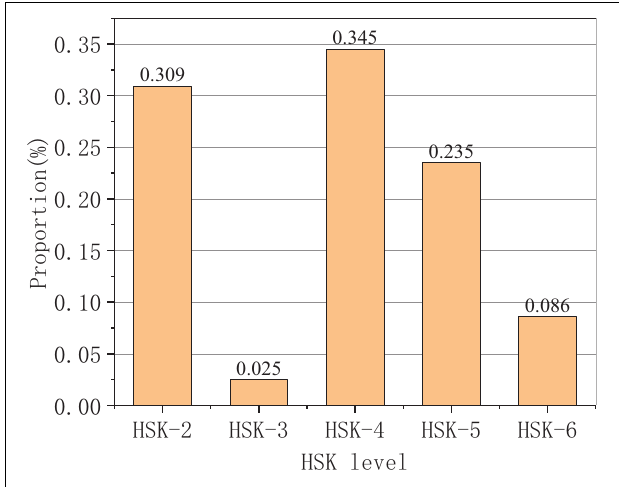
FIGURE 9 | Results of foreign students’ HSK level.